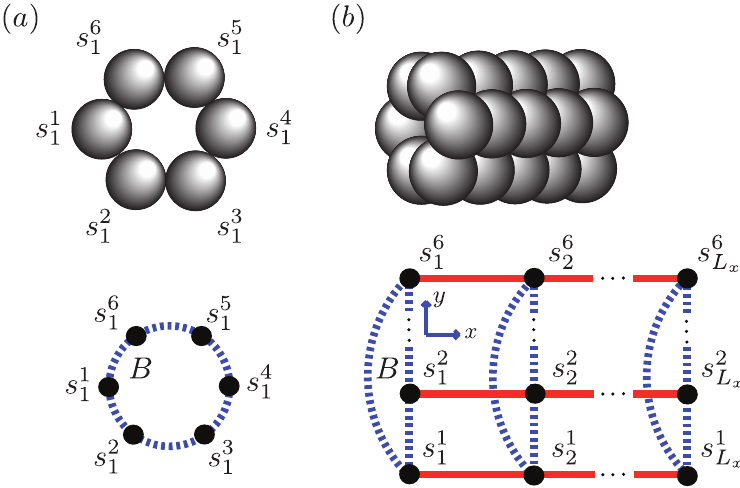
Figure 7. ( a ) A strip lattice with periodic boundary conditions in the y -axis is used to model the nucleus for A β (1-42) as a hexamer. The strip has L B (blue, dotted lines) is the free energy contribution from the interaction between proteins s j , s j +1 that are both sheet along the y -axis; ( b ) Oligomers aggregate along the x -axis with a i i → ∞ is the thermodynamic total of L sites, where L x x